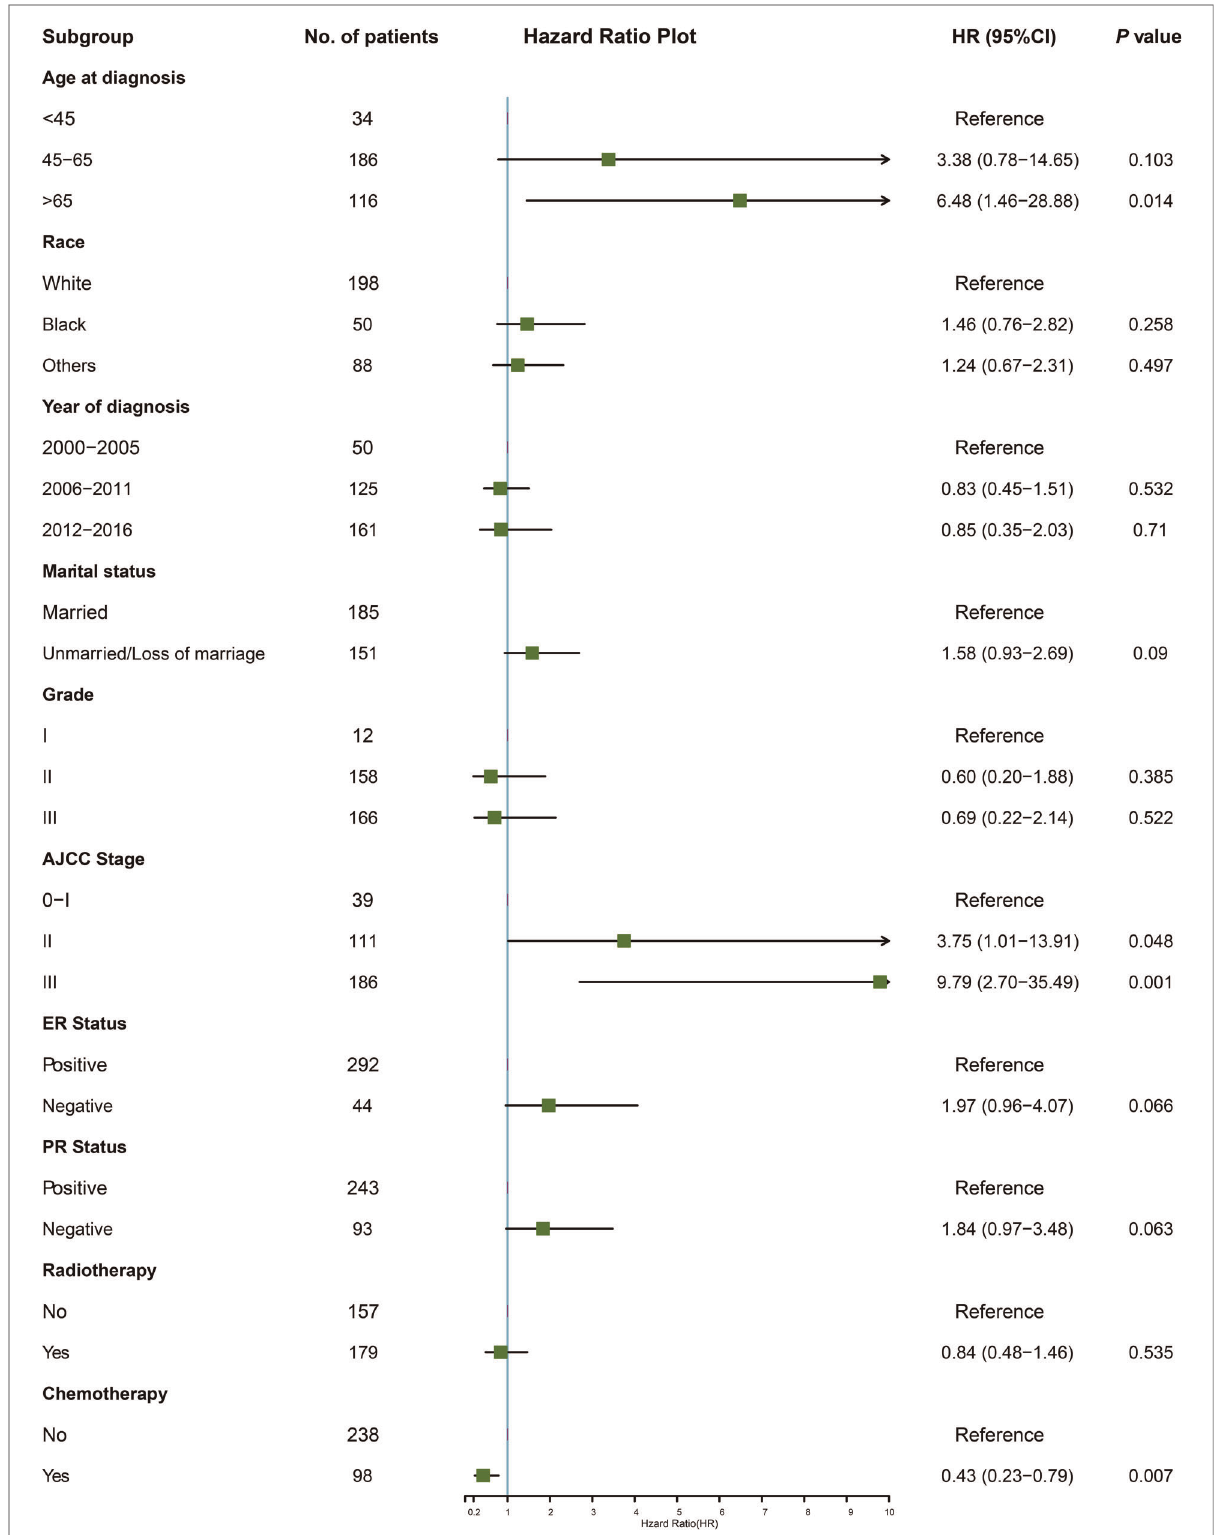
FIGURE 2 The forest plot for multivariate Cox analysis in the training cohort. AJCC, American Joint Committee on Cancer; ER, estrogen receptor; HR, hazard ratio; PR, progesterone